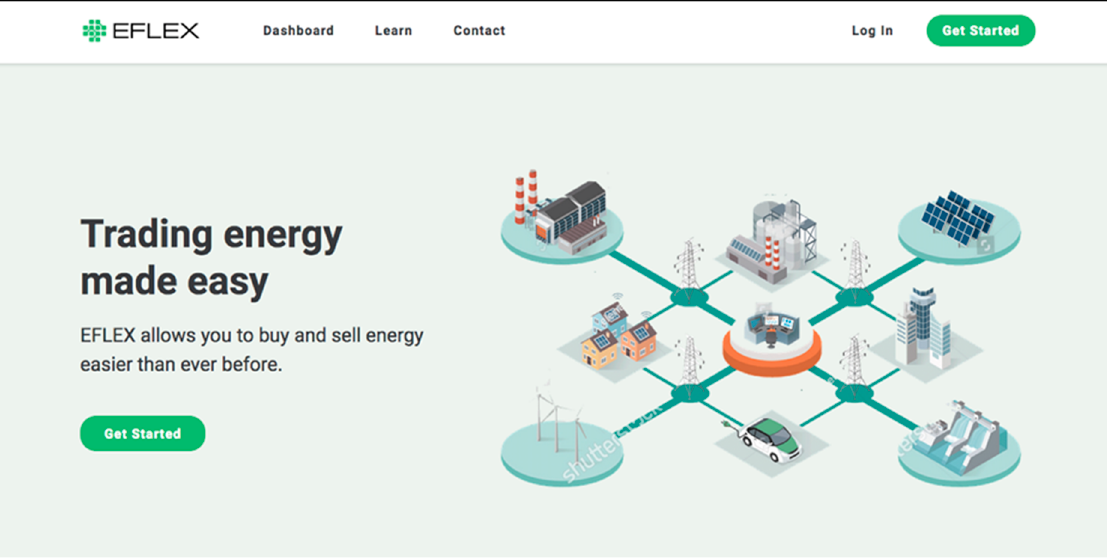
Figure 19. Welcome dashboard the trading eFLEX platform.